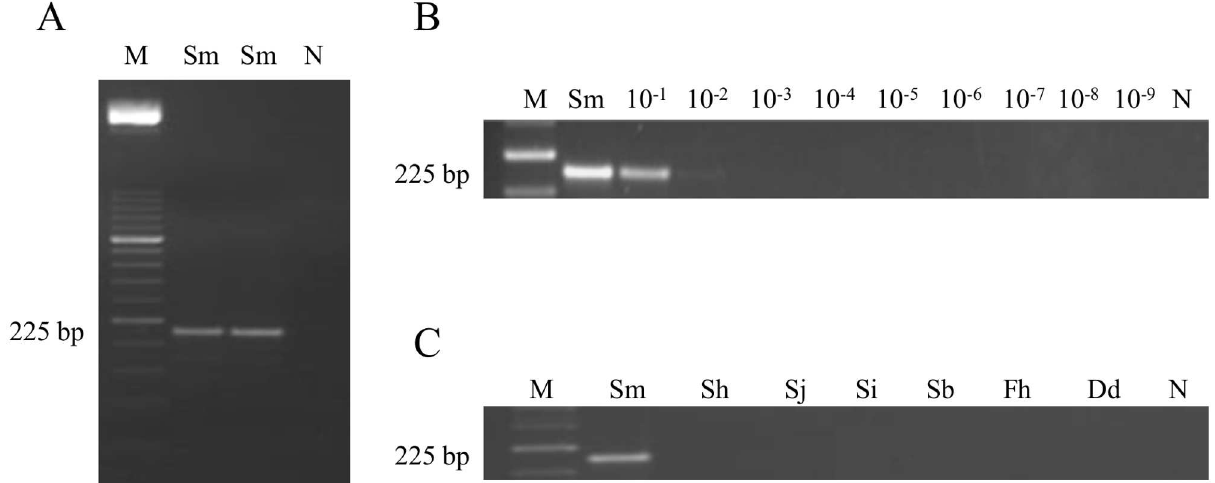
Fig 3. PCR verification, detection limit and specificity using outer primers F3 and B3. (A) PCR verification of expected225 bp target length amplicon.Lane M, 50 bp DNA ladder(Molecular weight marker XIII, Roche); lanes Sm, S . mansoni DNA (1 ng); lane N, negative control (no DNA template). (B) Detection limit of PCR. Lane M, 50 bp DNA ladder(Molecularweight marker XIII, Roche); lane Sm: S . mansoni DNA (1 ng); lanes 10 − 1 –10 − 9 : 10-fold seriallydilutionsof S . mansoni DNA; lane N, negativecontrol (no DNA template). (C) Specificity of PCR. Lane M, 50 bp DNA ladder(Molecular weight marker XIII, Roche); lanes Sm, Sh, Sj, Si, Sb, Fh, Dd, S . mansoni , S . haematobium , S . japonicum , S . intercalatum , S . bovis , Fasciola hepatica and Dicrocoelium dendriticum DNA samples (1 ng/each), respectively;lane N, negativecontrol (no DNA template).